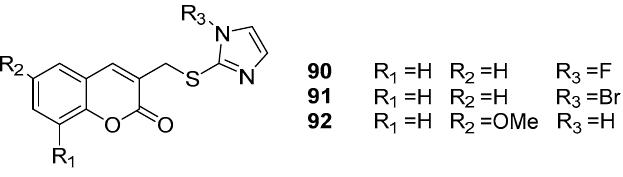
Figure 33. Anti-hepatitis coumarins.